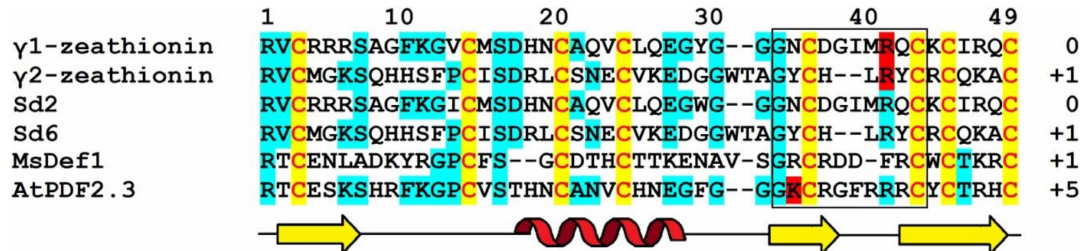
Figure 6. Sequence alignment of grass defensins with ion-channel blocking activity. MsDef1 and AtPDF2.3 defensins are included for comparison. Cysteine residues are shaded yellow, while identical amino acids are shaded cyan. Functionally significant residues are highlighted in red [53,54]. The position of β -strands (yellow) and the α -helix (red) are indicated below the figure. A black frame borders the γ -core. The γ -core charge values are shown on the